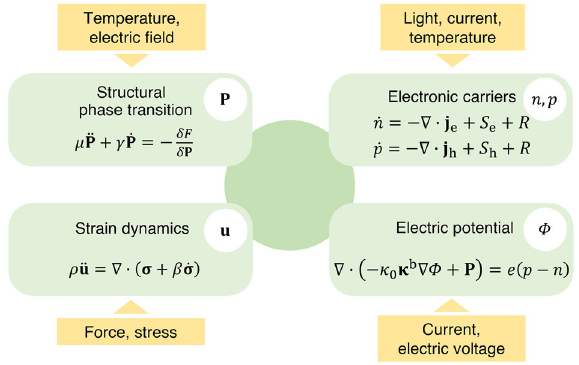
Fig. 2 Diagram of the governing equations of all degrees of freedom of the phase- fi eld model. 4 sets of independent variables are used to describe the electron-lattice system of a ferroelectric semiconductor, including the structural phase order (i.e., ferro- electric polarization) P , the mechanical displacement u , the free electron and hole concentrations n and p , and the electric potential Φ . The dynamics of these variables can be excited directly by various external stimuli or via the interplay among one-another. A combination of the governing equations of each of the variables yields a complete spatiotemporal description of the coupled dynamics of the charge carriers and structural